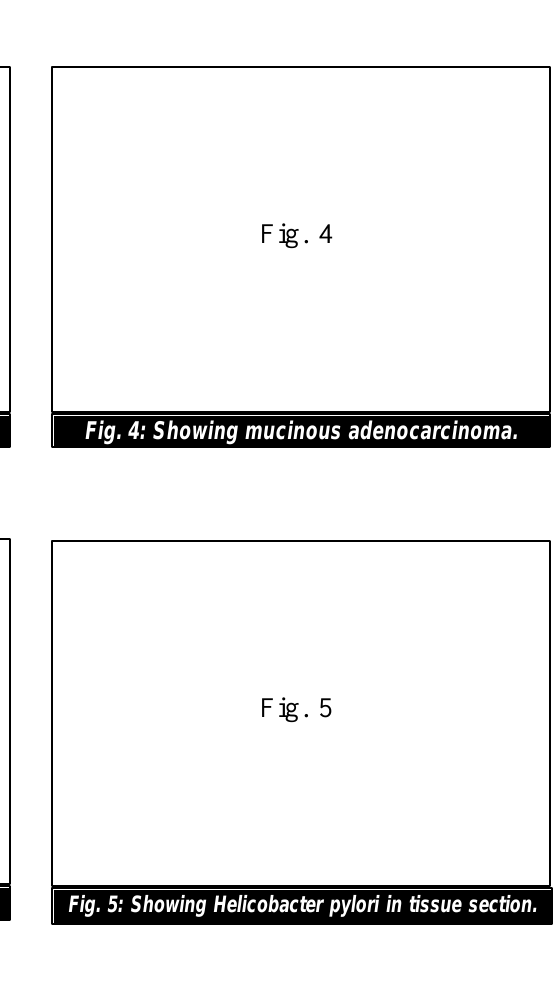
Fig. 2: Showing Signet-ring cell carcinoma.